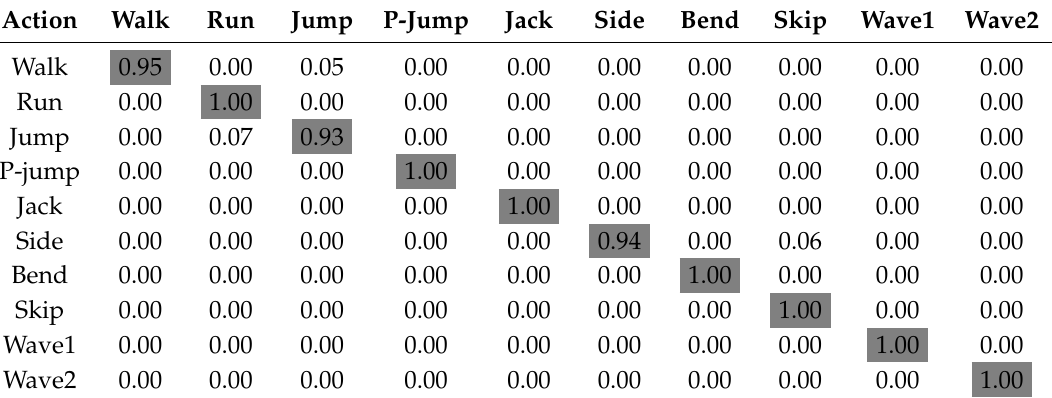
Table 1. Confusion matrix of Weizmann actions.